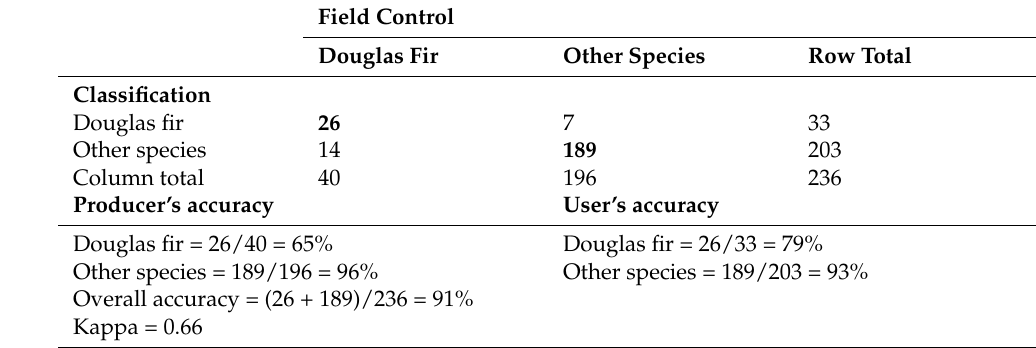
Table 9. Confusion matrix for Douglas fir trees from the smoothed watershed segmentation. Species were modeled using canopy steepness and percent cover. Segments were classified using a logistic generalized linear mixed model with a plot held as a random effect. Cottonwood trees were classified and removed from the dataset before this model was run; therefore, cottonwoods are excluded from the “other species”